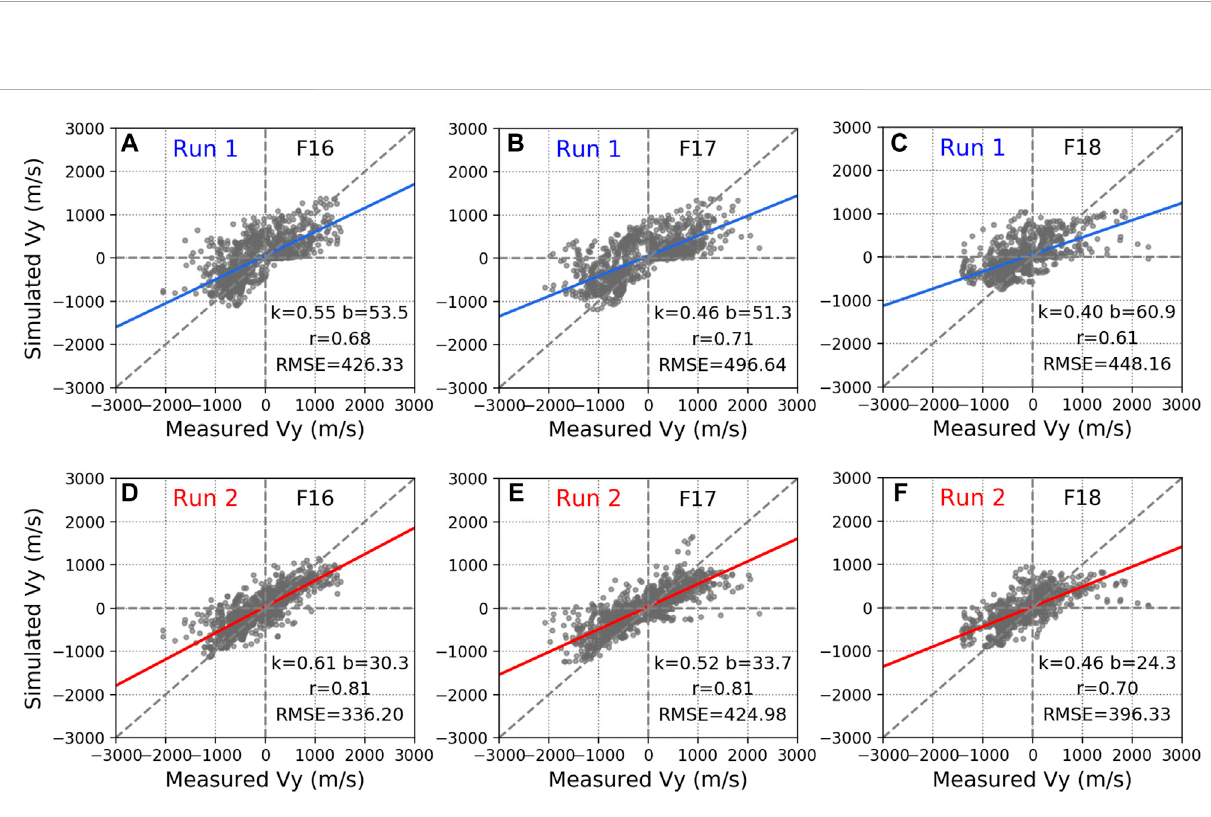
FIGURE 4 ScatterplotsofDMSP-measuredcross-trackiondriftV y versus correspondingGITMrun1(top,drivenbyempiricalmodels)andrun2(bottom,driven bydata-basedpatterns)- simulated V y for all trajectories ofF16 (A,D) , F17 (B,E) , andF18 (C, F) between18 UTon October 8 and09 UTon October 9.The straightlinesrepresentthebest- fi tline.Theslope(k),intercept(b),correlationef fi